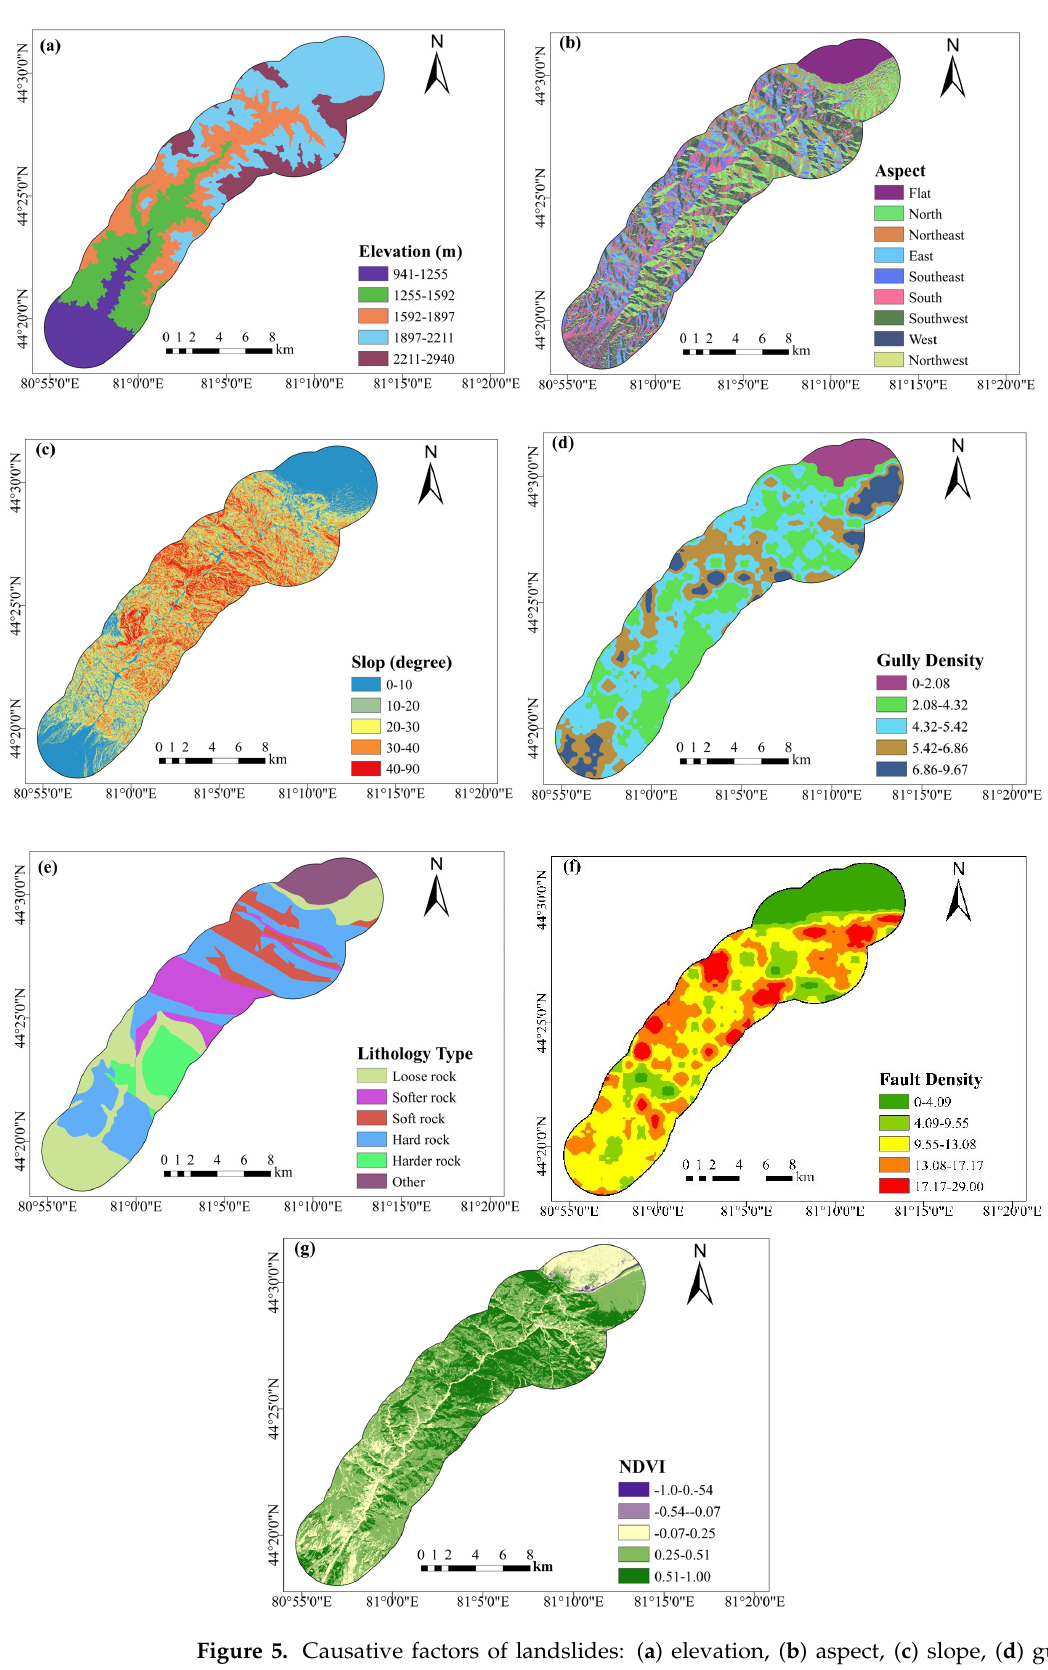
Figure 5. Causative factors of landslides: ( a ) elevation, ( b ) aspect, ( c ) slope, ( d ) gulley density, ( e ) lithology type, ( f ) fault density, and ( g ) NDVI.